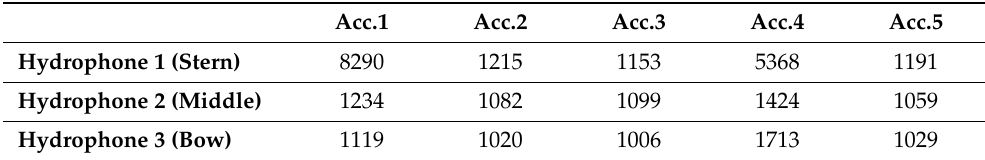
Table 1. Number of frequency bins for which the average of the Coherence Function is higher than the threshold (0.7) computed between each accelerometer and hydrophone.